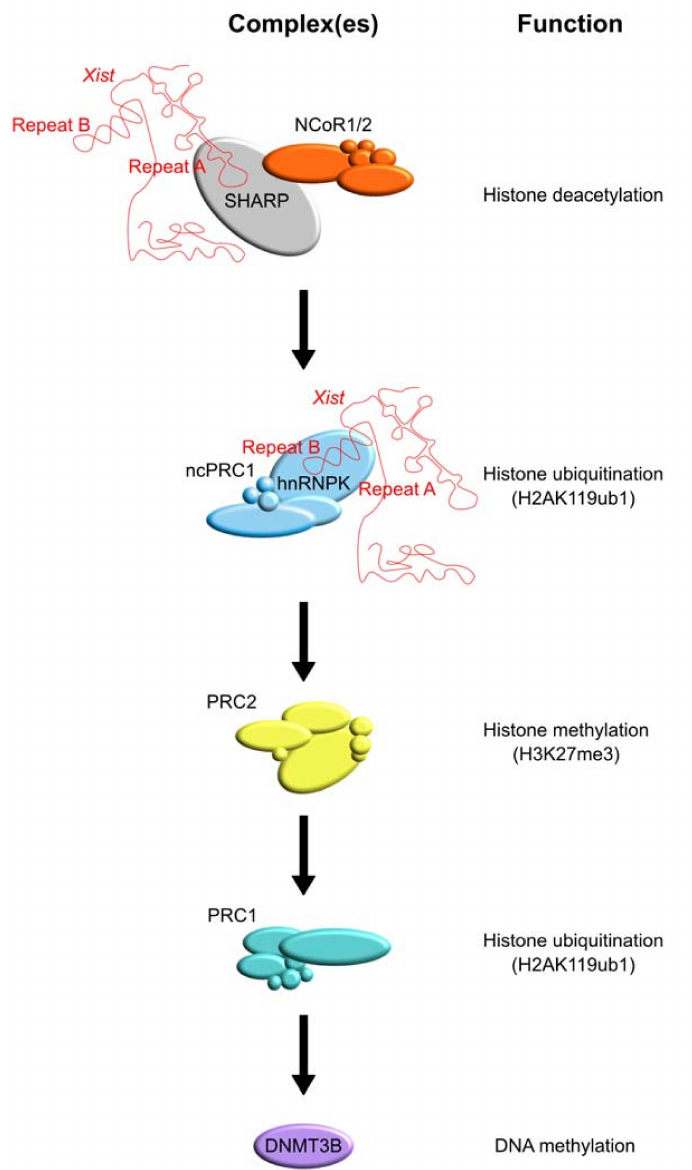
Figure 2. Proposed model for the silencing of the future inactive X chromosome (Xi) in female cells. The lncRNA Xist recruits SHARP [SMRT (silencing mediator for retinoid or thyroid hormone receptors) and HDACs (histone deacetylases)-associated repressor protein] to the X chromosome upon initiation of X chromosome inactivation (XCI). On one side, SHARP interacts with Xist through its RRMs (RNA recognition motifs) while on the other side it recruits chromatin modifiers through its highly conserved SPOC (Spen paralog and ortholog C-terminal) domain. One of the SPOC interactors is the multisubunit NCoR1/2 (nuclear receptor corepressor) complex that promotes histone deacetyla- tion through its subunit HDAC3. As a next step, Xist interacts with hnRNPK (heterogeneous nuclear ribonucleoprotein K) recruiting the non-canonical PRC1 complex (ncPRC1) that writes H2AK119ub1 through RING1A/B (really interesting new gene 1 isoform A/B). Subsequently, H2AK119ub1 is recognized by JARID2 (jumanji and AT-rich interaction domain-containing 2), subunit of the PRC2 complex that writes H3K27me3 through EZH2/KMT6A [enhancer of zeste 2/lysine (K) methyltrans- ferase 6A]. H3K27me3 is read by canonical PRC1 through its subunit CBX (chromobox-containing protein) and H2AK119ub1 is further established on the chromatin. Finally, silencing is achieved due to the activity of DNA methyltransferase 3B (DNMT3B) that methylates position 5 of cytosines (5 mC) within the